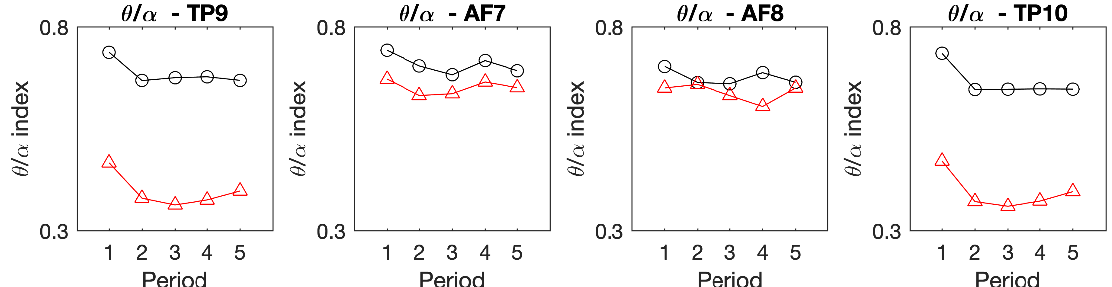
Figure 4. Within-session theta/alpha ratios by period. TP: Temporoparietal, AF: Anterior frontal, △ : Juingong meditation, ○ : IMW. The horizontal axis represents time, and the vertical axis represents the theta/alpha ratio. The total experimental time was 15 min, averaged for 3 min intervals, and displayed as a graph. The theta/alpha ratio is a value obtained by calculating the theta power and alpha power in each channel, and then using them as the numerator and denominator, respectively. In all areas, the theta/alpha ratio was lower in the Juingong meditation than in the IMW. The difference is particularly noticeable in the TP channels.